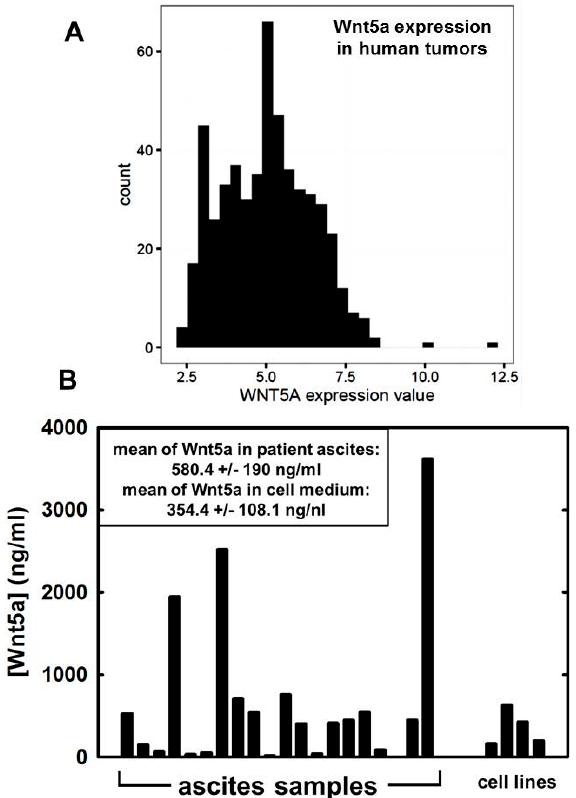
Figure 2. Wnt5a expression in human ovarian cancer. ( A ) Summary of WNT5A expression in human ovarian cancer. Data are obtained from The Cancer Genome Atlas (TCGA) and represent 583 ovarian cancer samples. Gene expression was measured using the Affymetrix microarray hgu133a. Data were normalized with gcrma and relative expression values (y-axis) are on a log2 scale [121]. Counts (x-axis) indicates the number of patients with a specific expression value x; ( B ) Analysis of Wnt5a protein levels in human ovarian cancer ascites. Ascites fluid was obtained from women with ovarian cancer. After centrifugation to remove cellular components, WNT5A levels were determined by ELISA using 100 uL of ascites. The mean concentration of WNT5A in ascites ( n = 20) is 584.4 ± 190 ng/mL. Similar levels are expressed by cultured ovarian cancer cell lines (OvCa 429, OvCa433, DOV13, SKOV-i.p.; mean 354.4 ± 108.1 ng/mL).